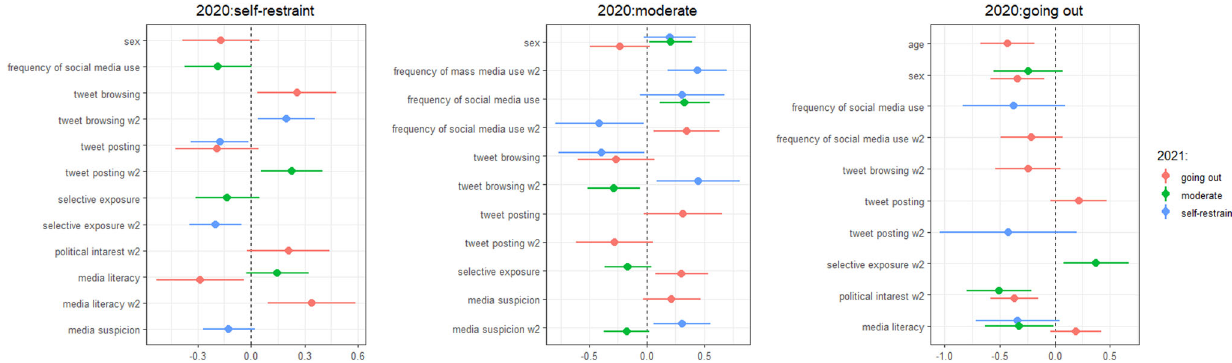
Fig. 3 Variables selected for predicting cluster shifts between time points in 2020 and 2021. Left: Self-restraint group; Middle: Moderate group; Right: Going out group. The panels show variables selected by stepwise methods and standardised coef fi cients with 95% con fi dence intervals. The variables in the second wave are suf fi xed ‘ w2 ’ , and the variables without suf fi x are in the fi rst